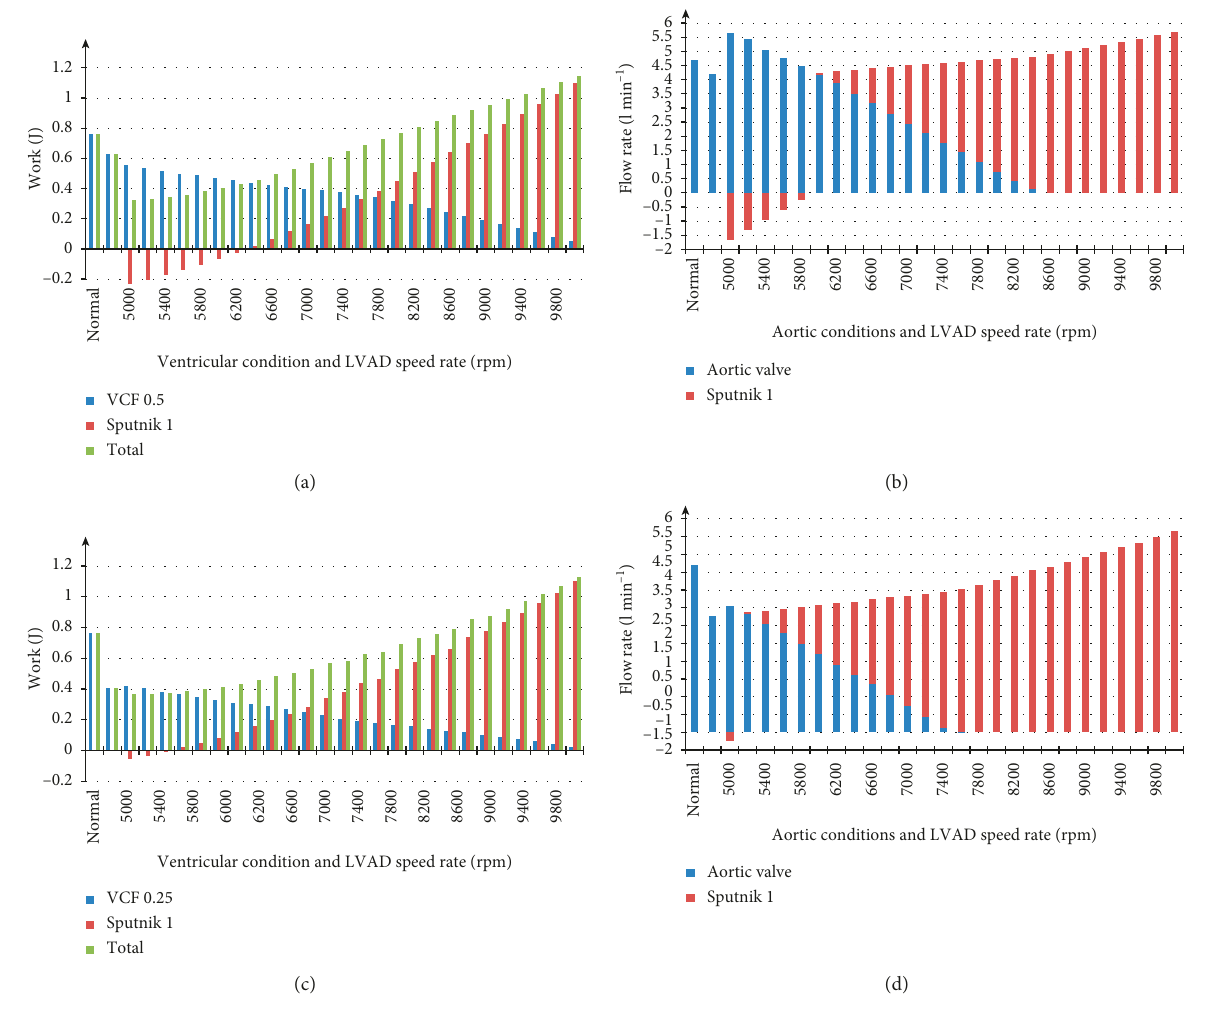
Figure 5: (a, c) Average levels of left ventricular stroke work, hydraulic pump work, and total work for Sputnik 1 LVAD supporting the adult LV with ventricular contractility factors (VCFs) of 0.5 and 0.25, respectively, in the pump speed range of 5000–10000rpm with 200rpm step. (b, d) Average aortic valve and pump flow rates with respect to normal, heart failure, and supported states in the pump speed ranges specified for Sputnik 1 LVAD supporting LV with VCFs of 0.5 and 0.25, respectively. Stroke work and aortic valve flow rates in normal and heart failure states are presented for